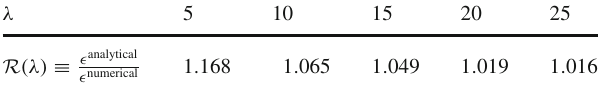
charged-Reissner–Nordström-black-hole- nonminimally-coupled-linearized-massless-scalar-field cloudy con- figurations. We present, for various values of the coupling parameter √ λ ≡ 2 |¯ η | [27] (see footnote 9) of the theory the dimensionless ratio R (λ) ≡ (cid:15) analytical /(cid:15) numerical between the analytically calculated value of the dimensionless critical parameter (cid:15) [as calculated directly from the resonance formula (38) for the fundamental n = 0 mode] and the corresponding exact values of the critical parameter as computed numerically in [27]. One finds that, in the large-coupling λ (cid:3) 1 regime of the composed Reissner–Nordström-black-hole-scalar-field cloudy configurations, the agreement between the analytically derived resonance formula (38) and the corresponding numerically computed resonance spectrum of [27] is remarkably good (see footnote 12) λ 5